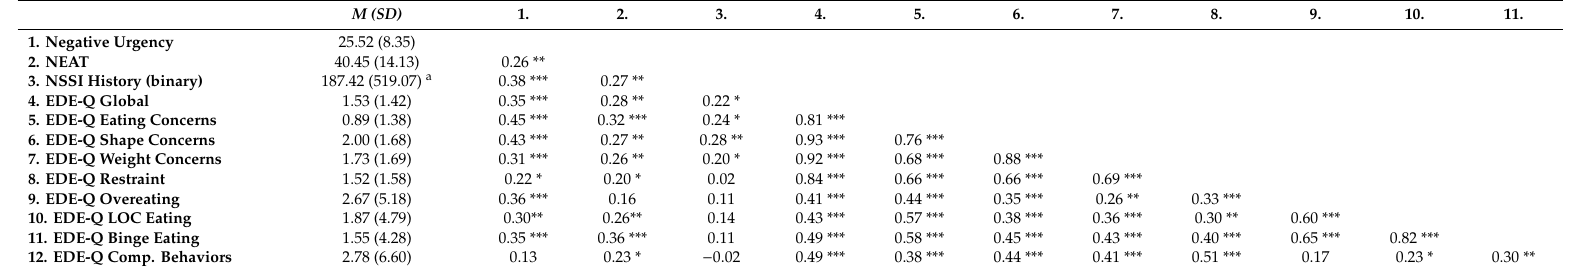
Table 2. Bivariate non-parametric (Spearman’s) correlations ( N =